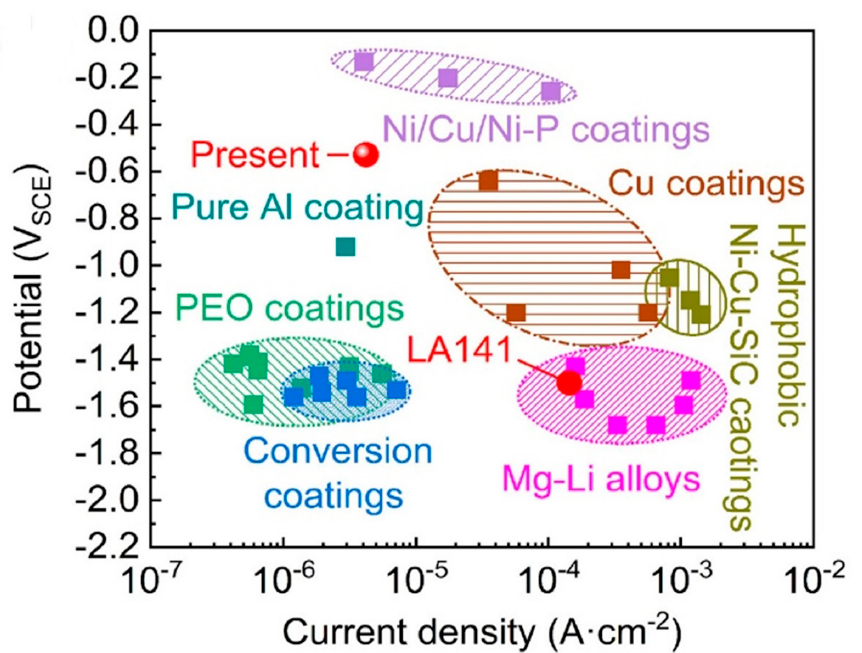
Figure 4. Corrosion potential and corrosion current density of Mg_Li alloys. Reprinted with permission from [105]. 2021, Y. J Sun.